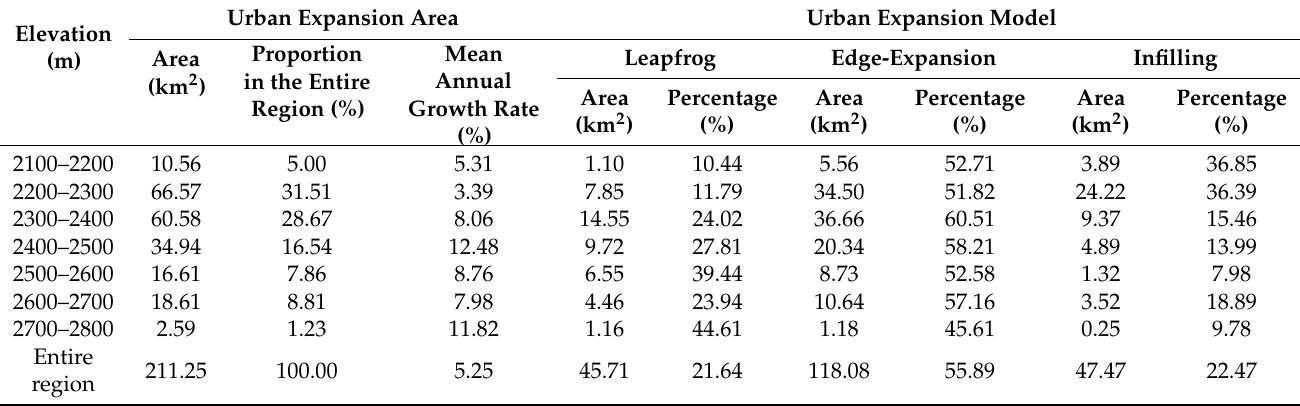
Table 2. The urban expansion area by altitude in Xining City from 1969 to